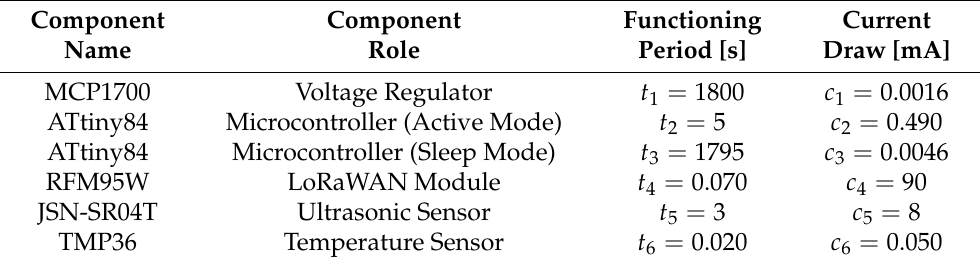
Table 1. Functioning periods and currents draws for each firmware cycle for each of the smart bin